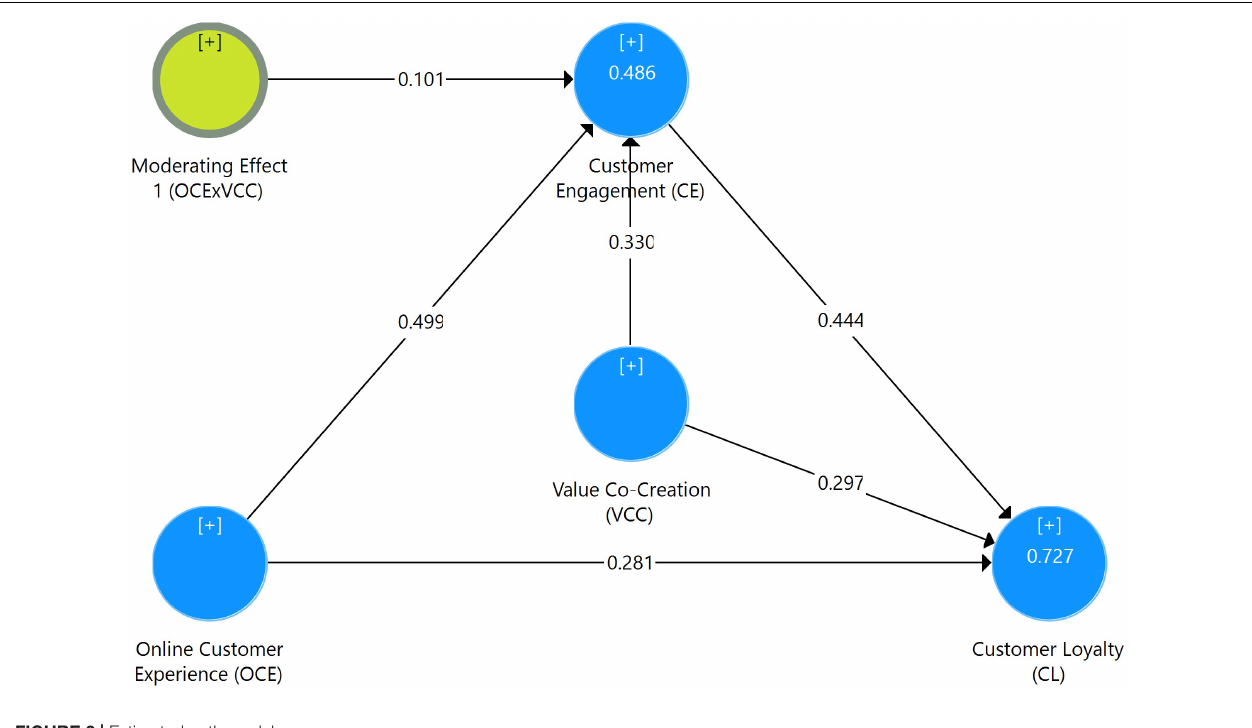
FIGURE 3 | Estimated path